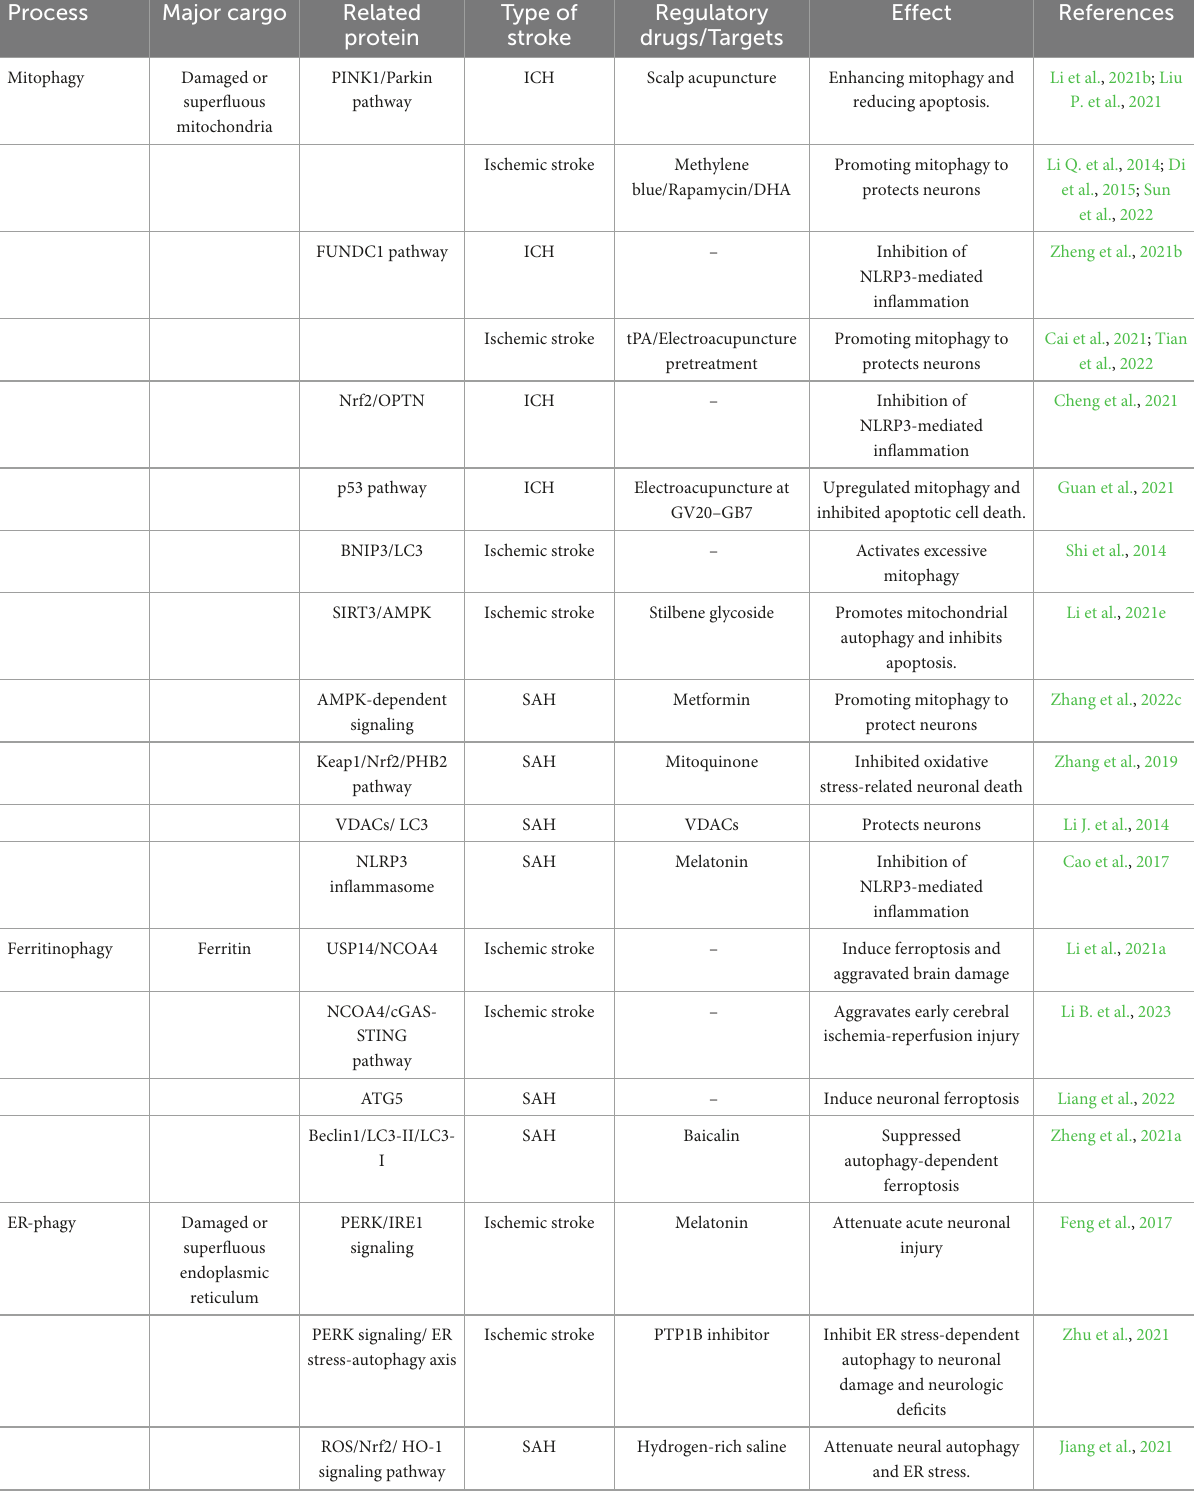
TABLE 1 Selective autophagy characteristics and effect in